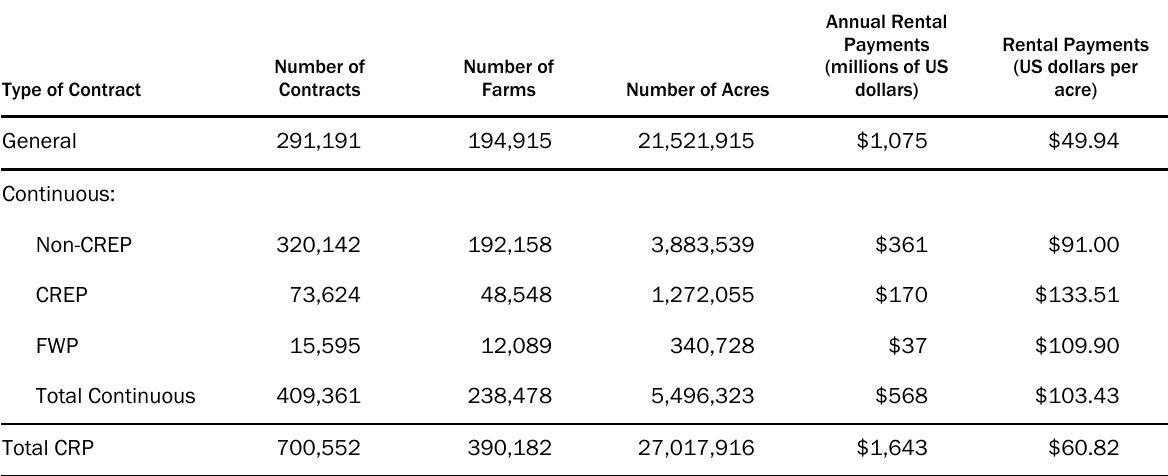
Table 2. Land Enrolled in Conservation Reserve Program